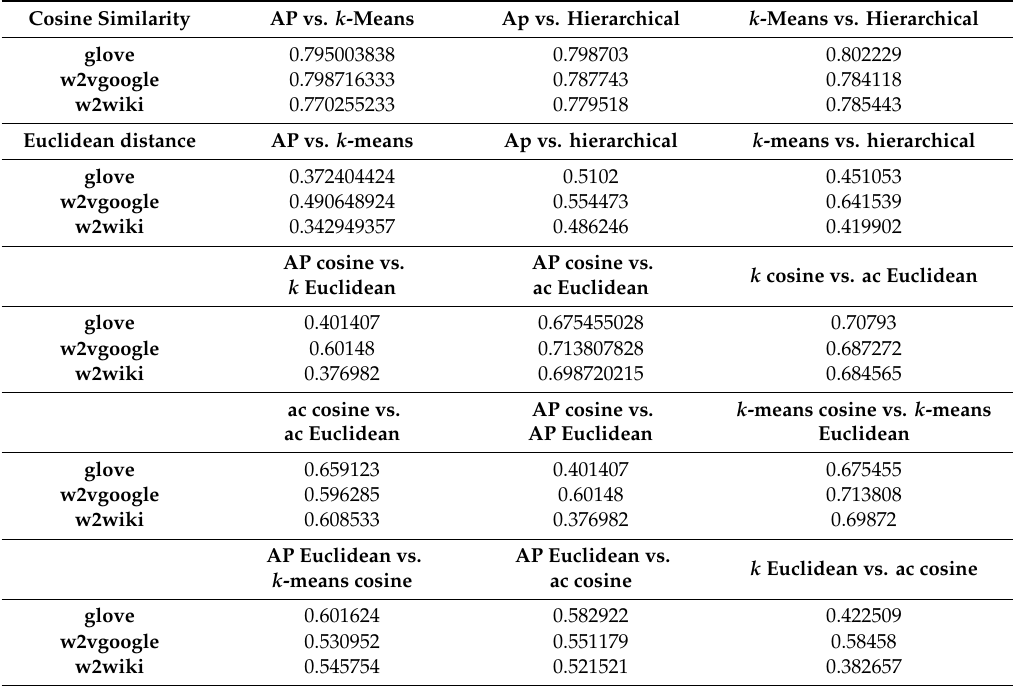
Table A2. SD coe ffi cients for word embedding models and clustering algorithms, on n gram.